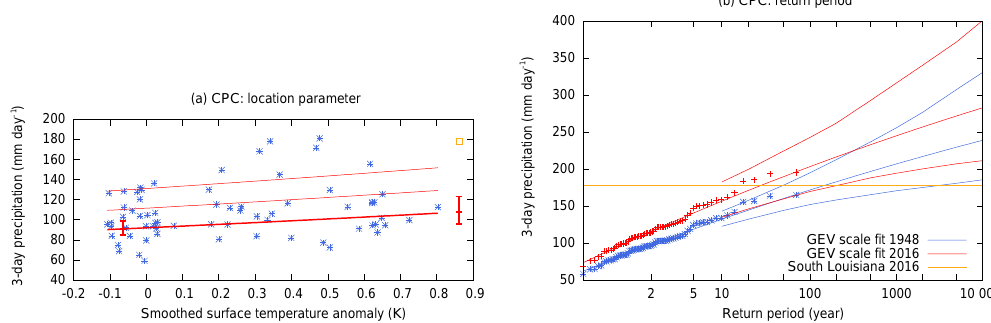
Figure 5. The same as Fig. 4 but for the spatial and annual maximum 3-day average of 1948–2016 0.25 ◦ × 0.25 ◦ gridded CPC analysis.